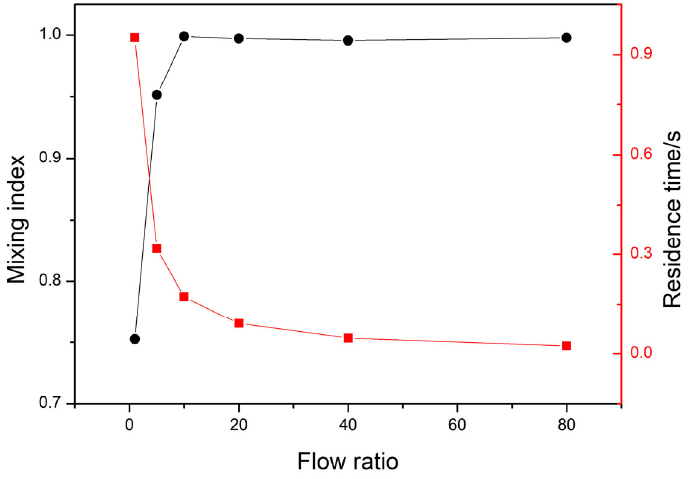
Figure 3. Influence of flow ratio on mixing index and residence